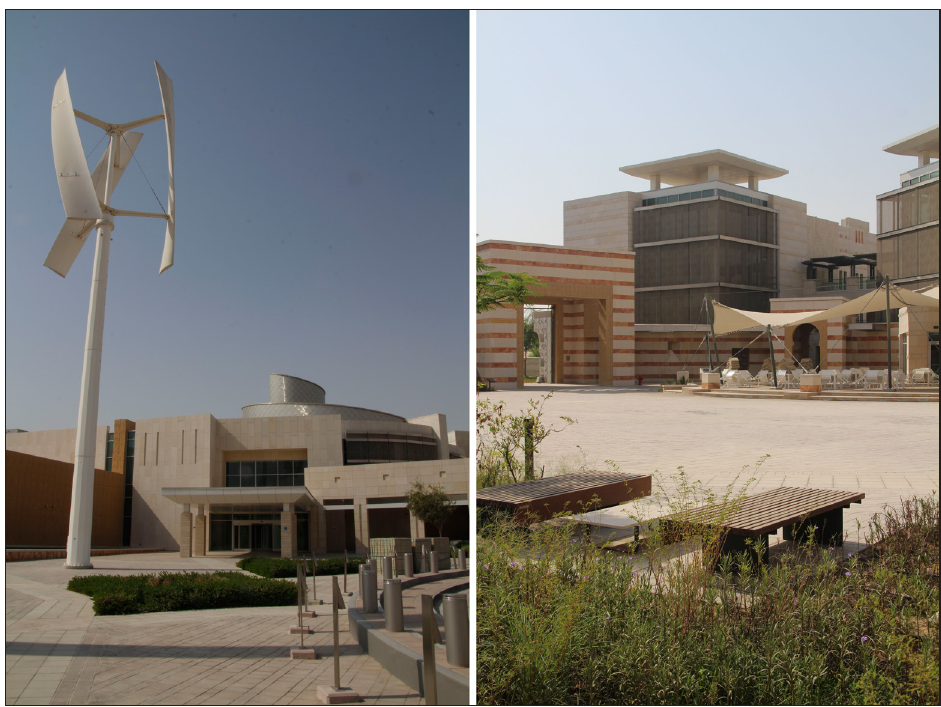
Figure 2: Education city